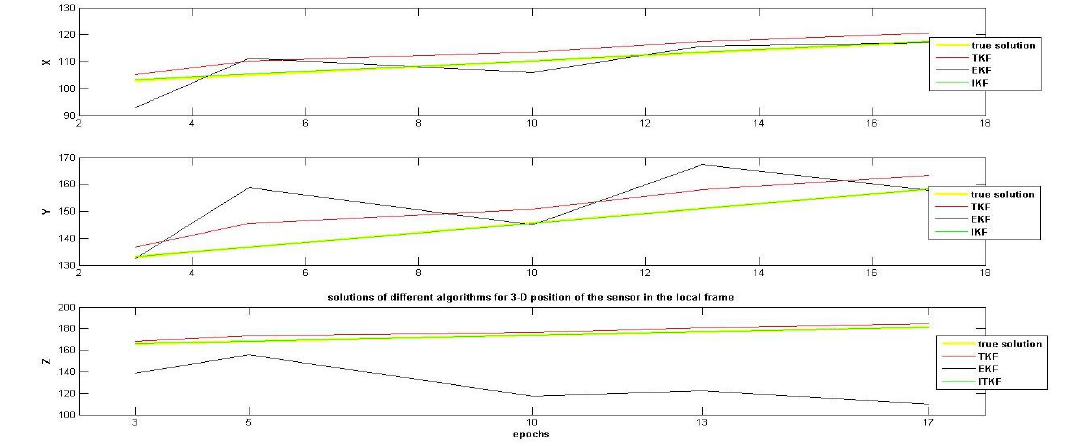
Figure 5: solutions of different algorithms for 3-D position of the mobile sensor in a local frame